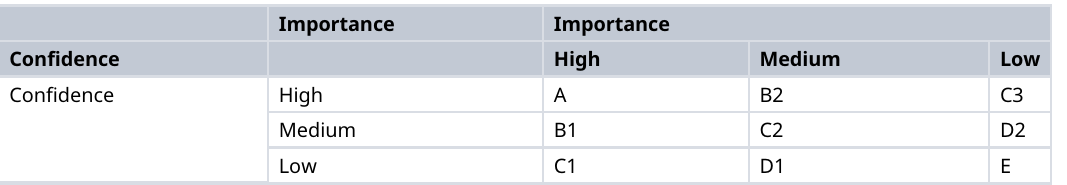
Table 1. Swing weights